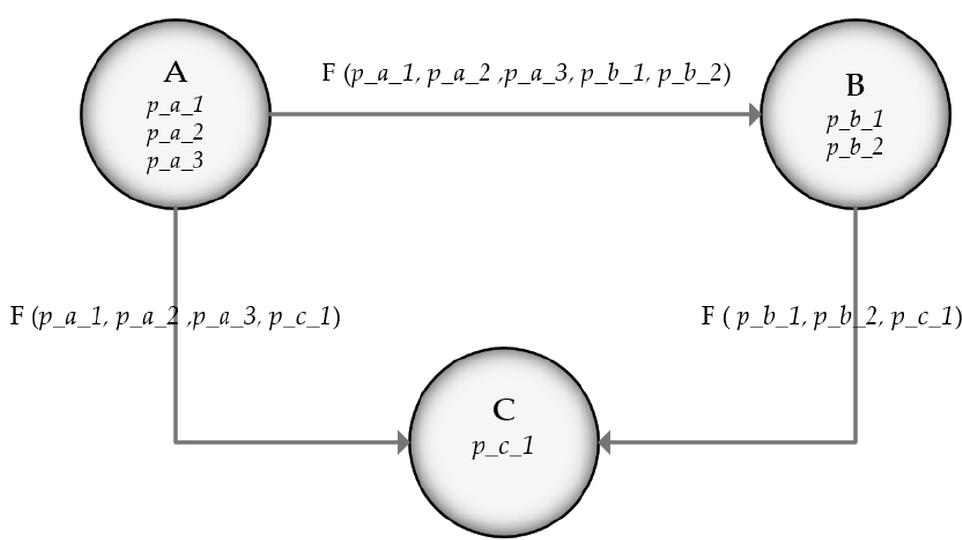
Figure 2. General weighted graph for multicriterial routing algorithm.